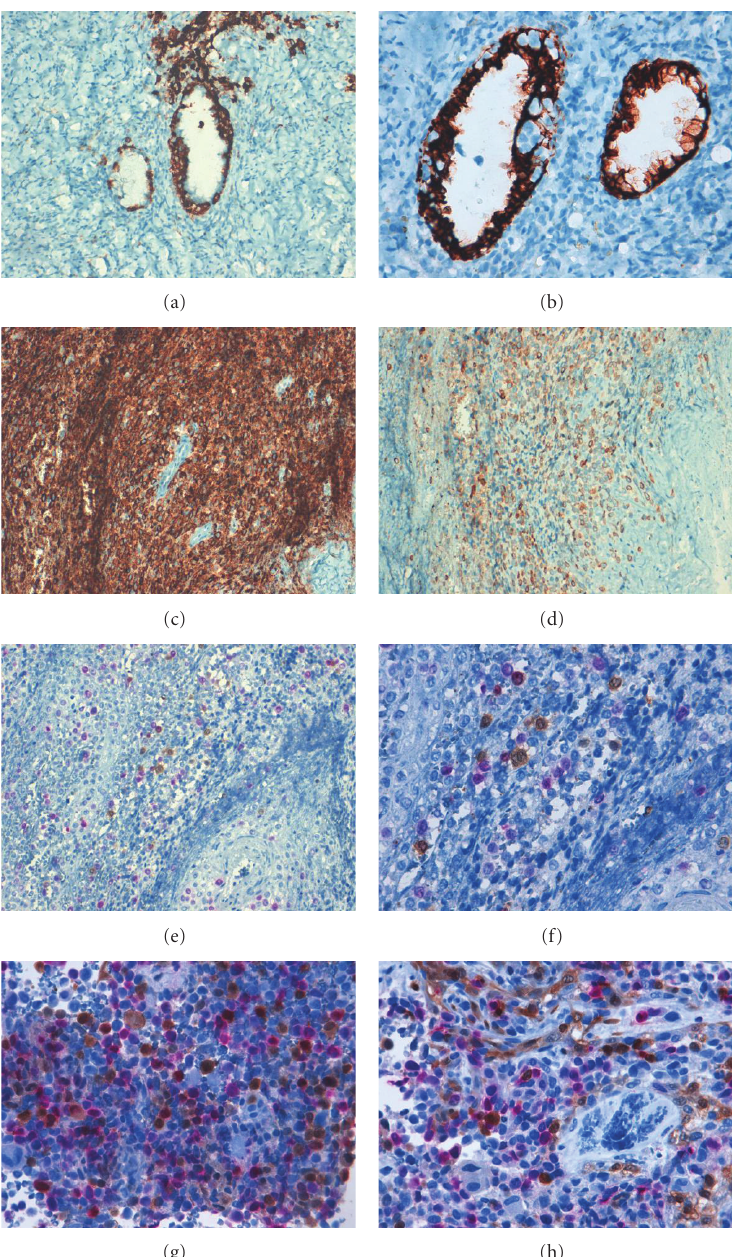
Figure 4: Uterine cervical malignant melanoma. Immunohistochemical studies. (a, b). S-100 and cytokeratin 7 expression. (c, d). HMB45 and Melan A positivity in neoplastic cells, respectively. (e, f, g, and h) CINtec Plus (Dual p16 + Ki-67), showing proliferate activity (red) and p16 (brown) positivity at nuclear and cytoplasm malignant cells.